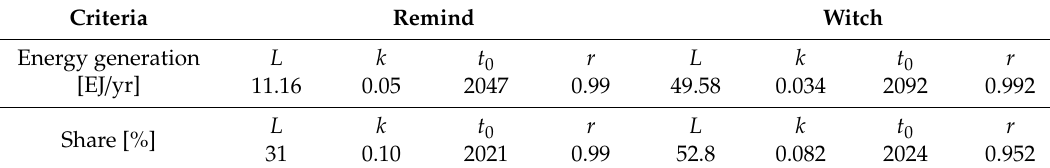
Figure 9. Europe Wind technology energy generation development based on Reference Scenario of REMIND until year 2100 (own work).